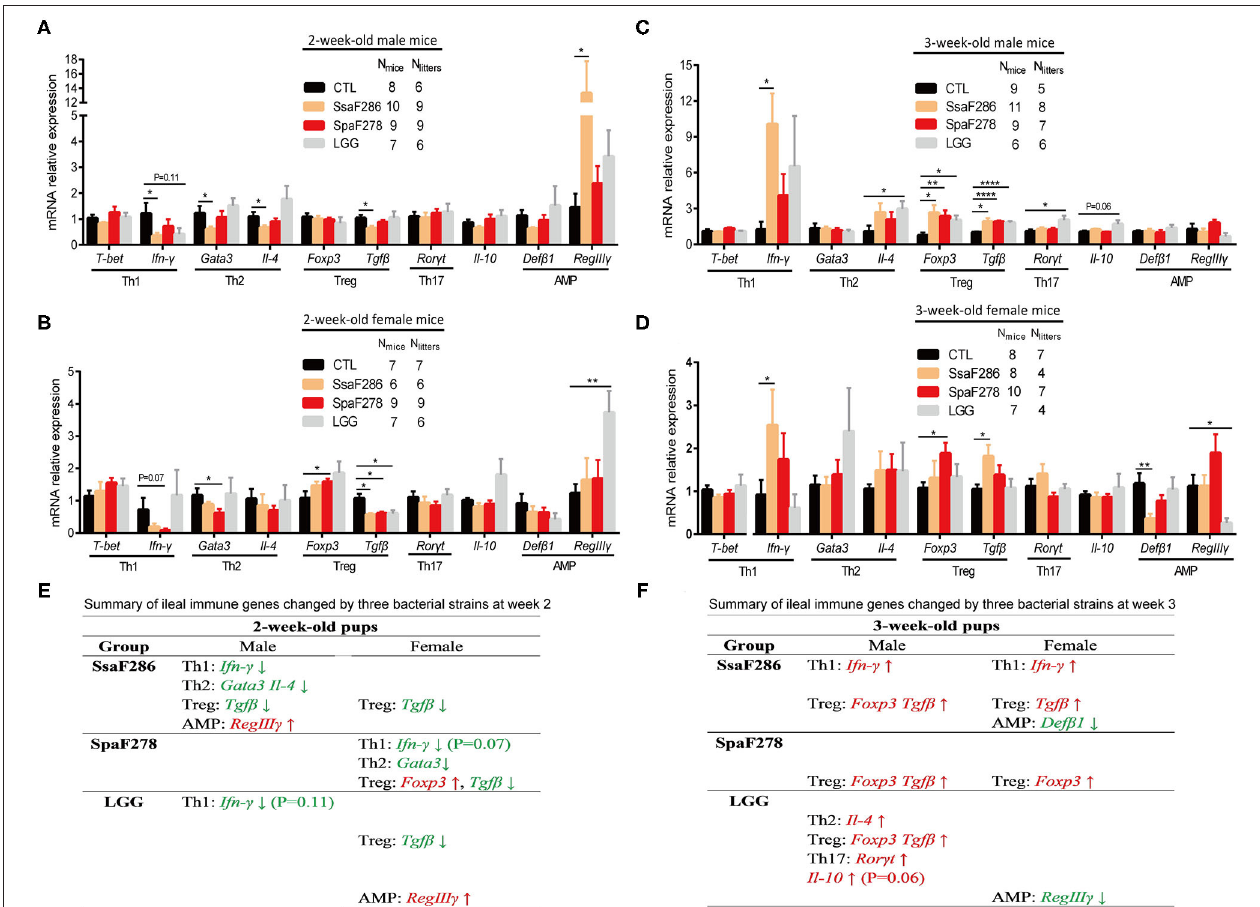
FIGURE 4 | S. salivarius F286, S. parasanguinis F278 and LGG modulated the ileal expression of immune genes in 2- and 3-week-old mouse pups. (A–D) mRNA expression levels of ileal transcription factors and cytokines representative of four Th cell lineages and antimicrobial peptides in 2-week-old male (A) and female (B) pups and in 3-week-old male (C) and female (D) pups. All mRNA quantification data were normalized to the housekeeping gene β -actin . Gene expression levels were expressed as values relative to the control (CTL) group. Data are presented as the mean ± s.e.m. The data of S. salivarius F286-, S. parasanguinis F278- and LGG-fed animals were compared to those of control animals with Student’s t test. * p < 0.05; ** p < 0.01; **** p < 0.0001. (E,F) Summary of ileal immune genes that tended to be ( p values provided in the parentheses following the gene) or were significantly changed by individual bacterial strains at the age of 2 weeks (E) and 3 weeks (F) . Genes in green and red are decreased and increased, respectively, by the bacteria. AMP, antimicrobial peptides; CTL, Control group; SsaF286, S. salivarius F286 group; SpaF278, S. parasanguinis F278 group; LGG, LGG